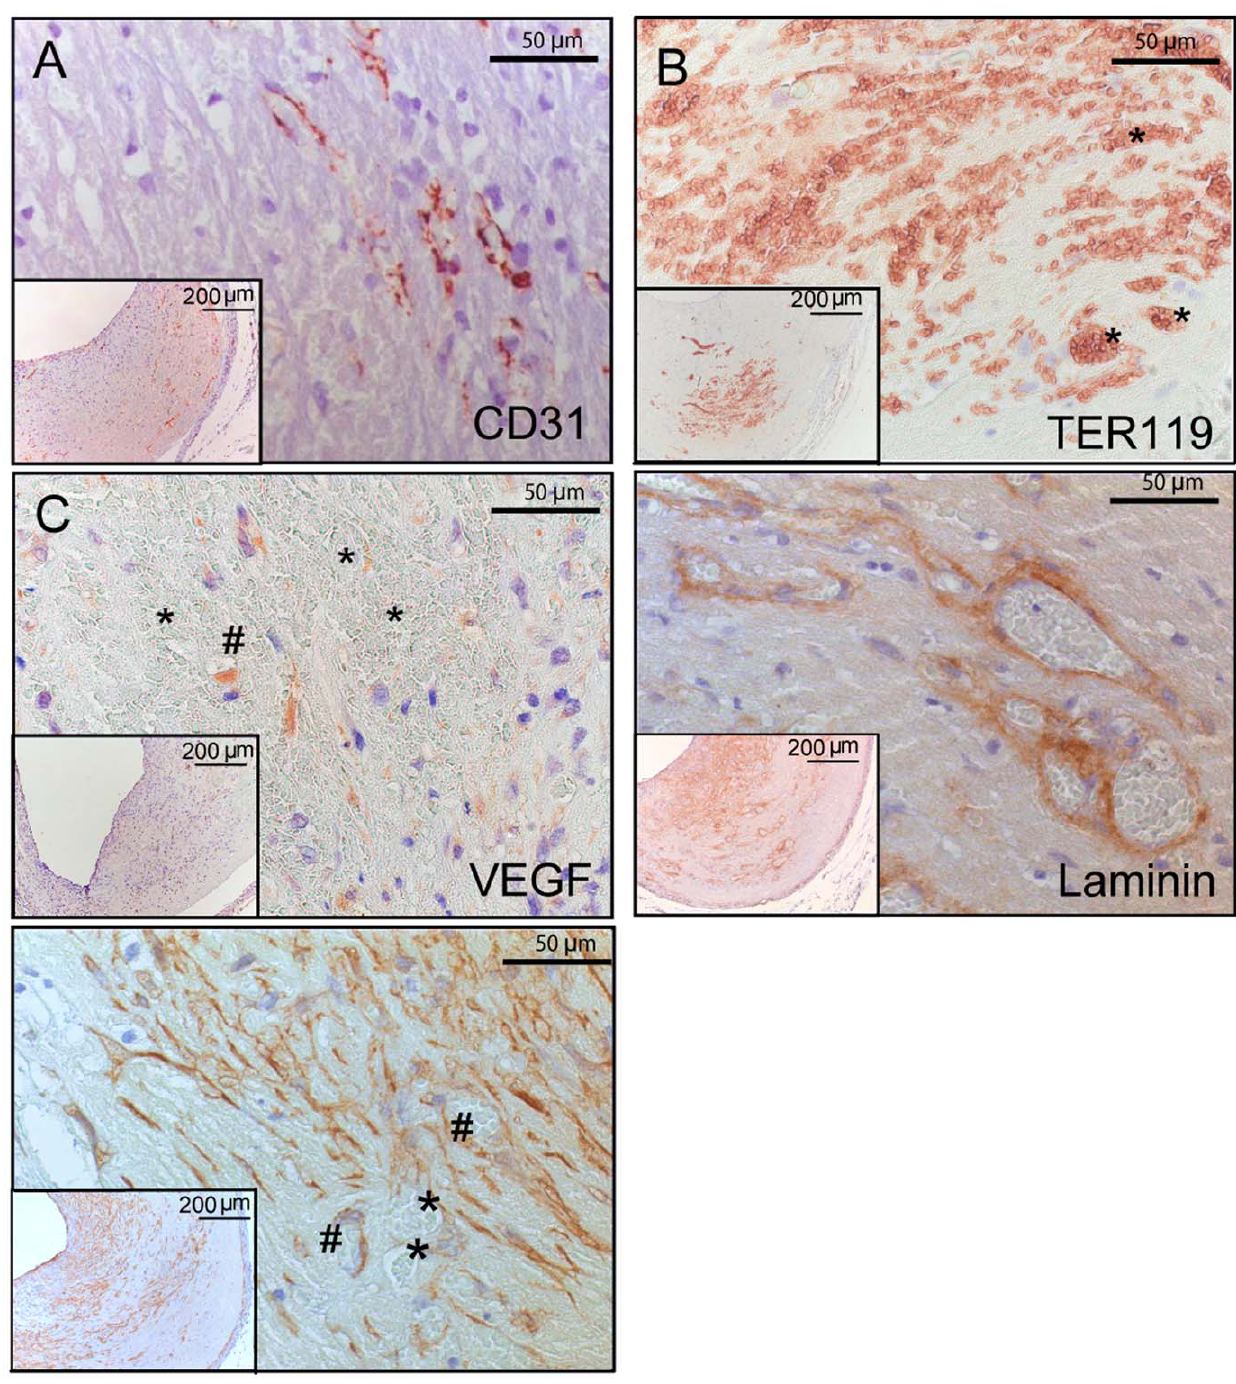
Figure 2. Vein graft lesions show clear neovascularization. A ; Endothelial cell staining (CD31) of neovessels in a vein graft lesion. B ; Erythrocytes are clearly visible in (*) and outside neovessels indicating that leaky vessels are present. C ; VEGF staining of a vein graft with extravasated erythrocytes (*), a VEGF positive neovessel is depicted with # . D ; Basement membrane staining with antibodies directed to laminin. Most neovessels in vein grafts stain positive. E: SMC staining of a vein graft. # marks SMC positive neovessels and * depicts neovessels lacking pericytes. These neovessels without pericytes are frequently found in regions with extravasated erythrocytes. Insets are 10x magnifications of vein grafts. doi:10.1371/journal.pone.0047134.g002 frequently seen close to the lumen suggesting a cap-like grafts are repopulated to an almost intact endothelium (black arrows figure 1B and Figure S1A (CD31 staining)) within 28 days. organization (white arrows, figure 1B and Figure S1B (SMC actin The vein graft lesion consists of a dense network of ECM and staining). Accumulations of lipid-laden foam cells were primarily smooth muscle cells (SMC). Circular orientated SMC were found underneath the cap (Figure S1C (MAC-3 staining).